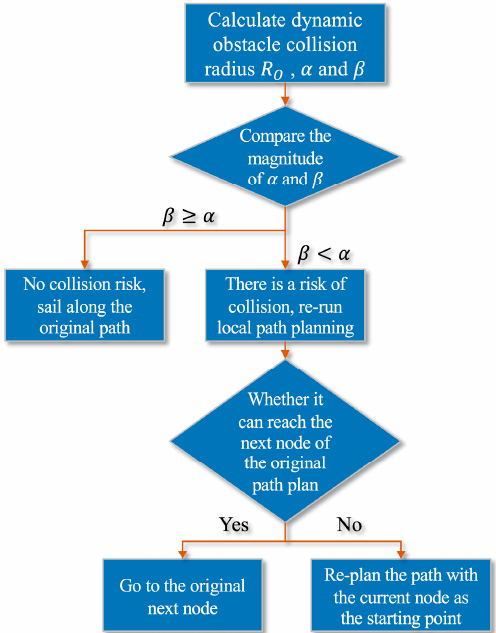
Figure 10. Dynamic obstacle avoidance algorithm flow chart.